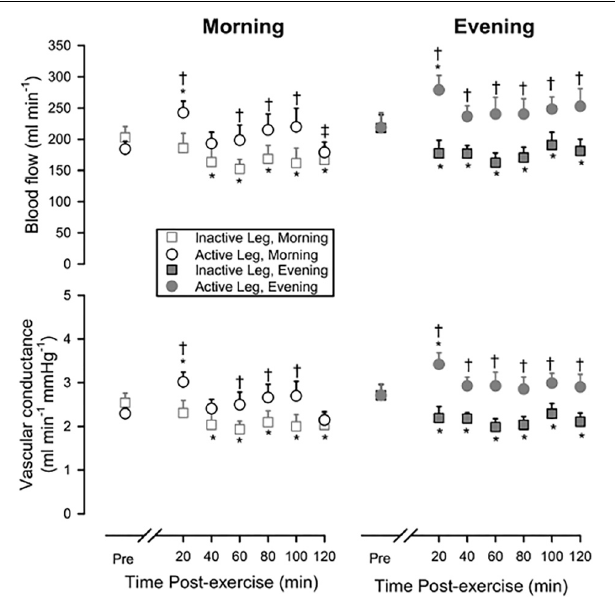
FIGURE 1 | Leg blood flow (upper panels) and leg vascular conductance (lower panels) pre-exercise and during 120 min of recovery from exercise in Morning (left panels) or Evening (right panels) sessions, showing both the response in the Active Leg and the Inactive Leg. Open squares: Inactive Leg during Morning session; Open circles: Active Leg during Morning session; Filled squares: Inactive Leg during Evening session; Filled circles: Active Leg during Evening session. Prior to exercise, blood flow and vascular conductance did not differ between Active Leg and Inactive Leg or between Morning and Evening sessions. ∗ P < 0.05 vs. pre-exercise; † P < 0.05 Active Leg vs. Inactive Leg; ‡ P < 0.05 Morning vs. Evening. Means ± SE; n =